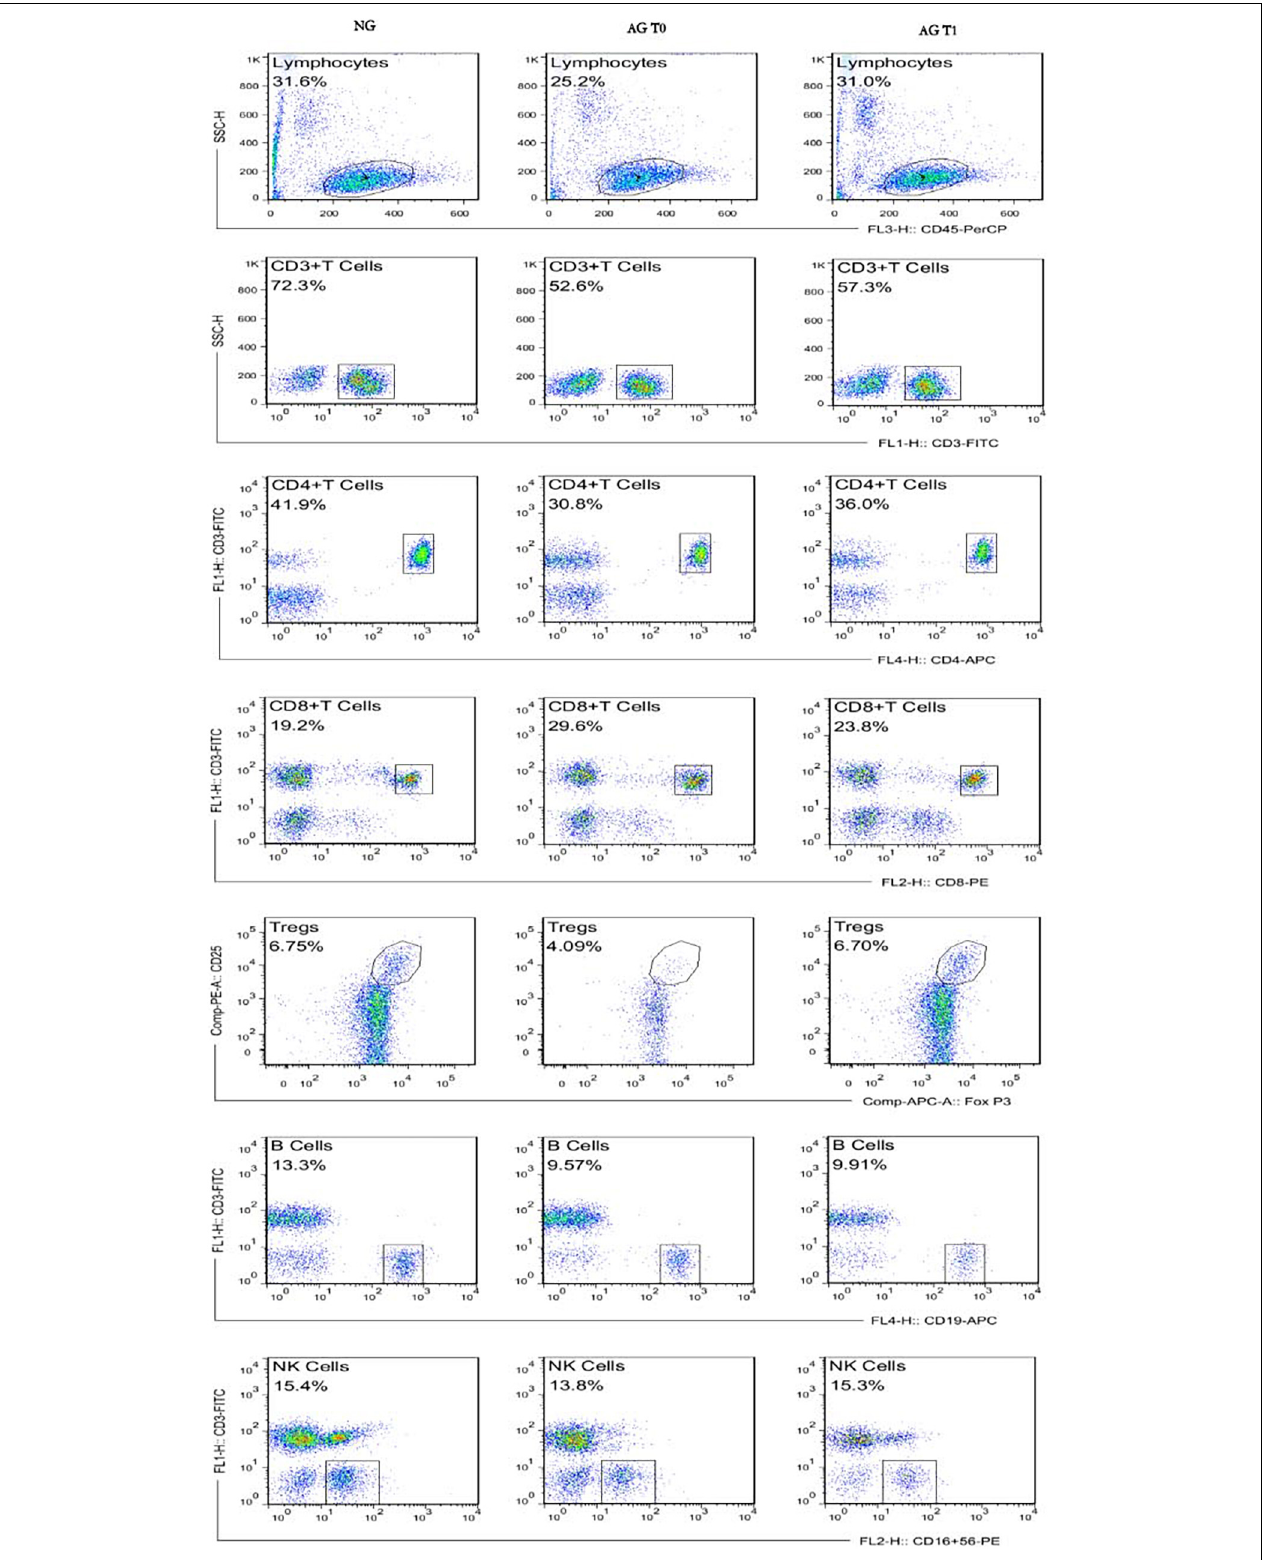
FIGURE 5 | Comparison of lymphocyte subsets in peripheral blood of different groups.